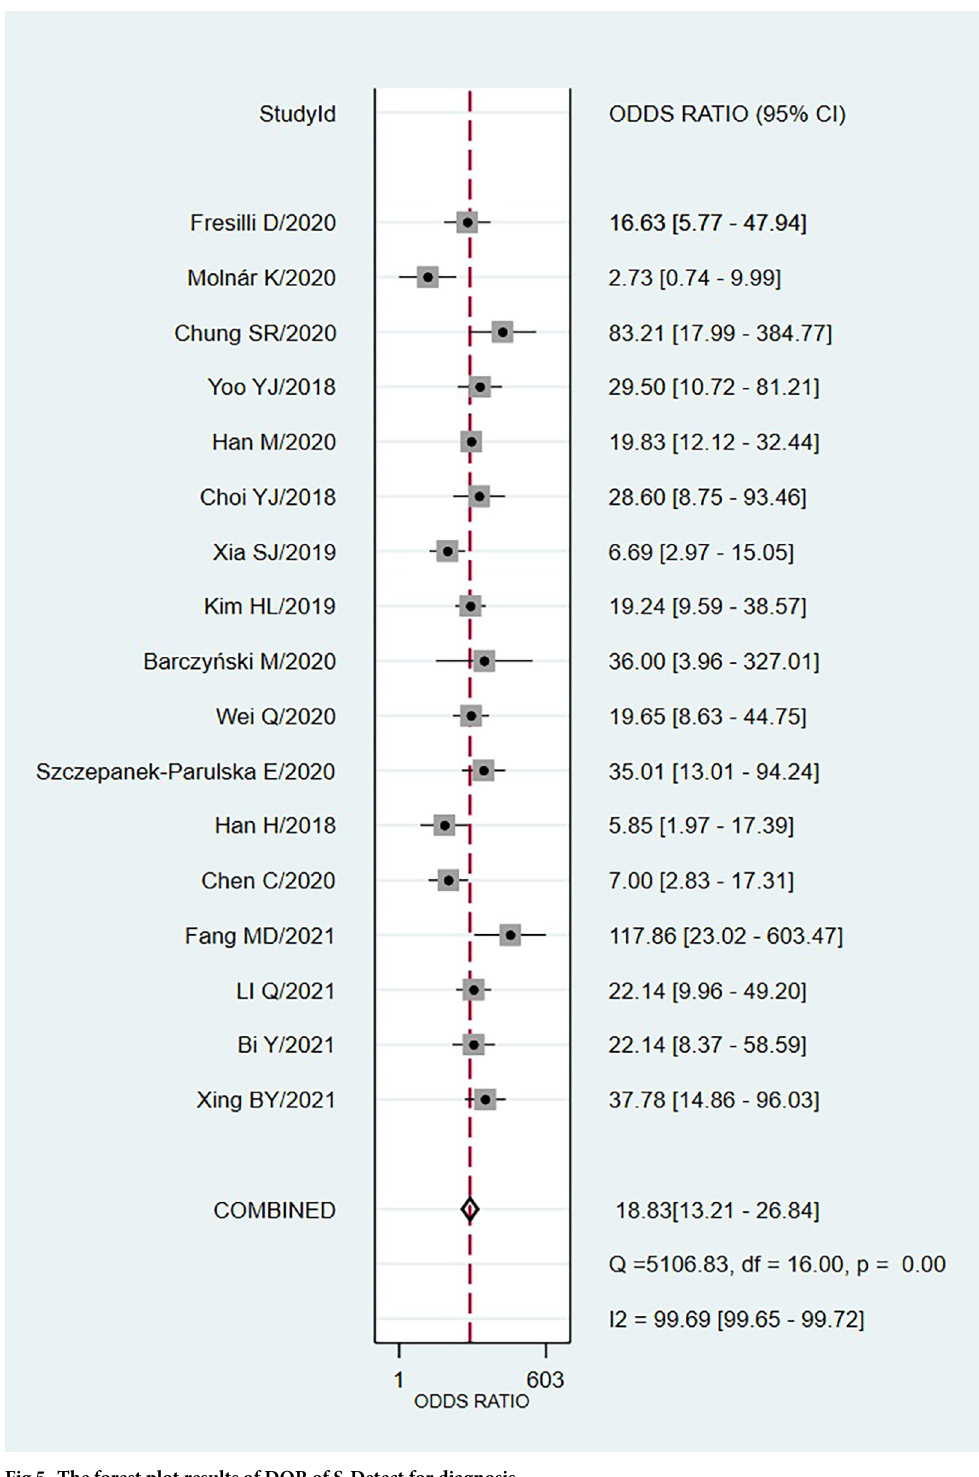
PLOS ONE | https://doi.org/10.1371/journal.pone.0272149 August 5,